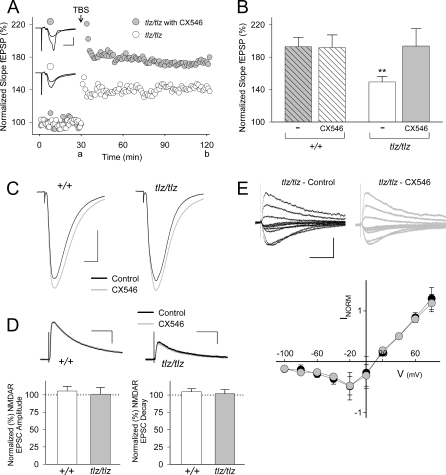
The Ampakine CX546 Restores the tbLTP Deficit in Neto1-Null Mice and Increases AMPAR, but Not NMDAR, EPSC Amplitude at Schaffer Collateral-CA1 Synapses(A) Scatter plots of normalized fEPSP slope plotted every 1 min from two individual representative Neto1-null slices without (white circle) or with (gray circle) CX546 (25 μm). When present, CX546 was applied to ACSF beginning 20–30 min before theta-burst stimulation. Theta-burst stimulation (TBS) was delivered to Schaffer collateral-CA1 synapses at the 30-min time point. The fEPSP slope was normalized with respect to the mean slope of fEPSPs recorded during the 10-min period immediately before theta-burst stimulation. Inset: average of six consecutive fEPSPs recorded at the times indicated (a or b; scale bars: 10 ms, 0.5 mV).(B) Histogram showing theta-burst stimulation-induced increase in fEPSP slope 90 min after theta-burst stimulation in slices from Neto1-null mice (tlz/tlz) without CX546 (-, white bar; n = 17 slices) and with CX546 (filled bar; n = 9 slices) and in Neto1+/+ mice without CX546 (-, filled hatched bar; n = 20 slices) and with CX546 (white hatched bar; n = 7 slices). Results are expressed as a percentage of normalized slope fEPSP. **, p < 0.01 versus tlz/tlz with CX546 (filled bar).(C) Representative traces show AMPAR EPSCs (held at −70 mV) before (black traces) and 20 min after CX546 (25 μM; gray traces) administration in hippocampal slices from Neto1+/+ (+/+) and Neto1-null (tlz/tlz) mice. Each EPSC is the average of six consecutive traces. Scale bars: 20 ms, 200 pA.(D) Representative traces show NMDAR EPSCs (+60 mV) before (black traces) and 20–30 min after CX546 (25 μM; gray traces) administration in hippocampal slices from Neto1+/+ (+/+) and Neto1-null (tlz/tlz) mice. Each EPSC is the average of six consecutive traces. Scale bars: +/+, 100 ms, 75 pA; tlz/tlz, 100 ms, 35 pA. Below: Histogram of pharmacologically isolated NMDAR EPSC amplitude (left) or decay (right) from CA1 neurons in hippocampal slices from +/+ (n = 8 neurons) and tlz/tlz (n = 6 neurons) mice 20–30 min after CX546 administration (25 μM; filled bars). Results are expressed as a percentage of NMDAR EPSC amplitude or decay with the amplitude or decay in +/+ and tlz/tlz slices before CX546 treatment normalized to 100% (dotted line).(E) Top: superimposed NMDAR EPSC traces at V
m from −100 to +80 mV in steps of 20 mV (scale bars: 100 ms, 70 pA) from a tlz/tlz hippocampal CA1 neuron before (black traces) and 20 min after CX546 administration (gray traces). Bottom: Summary scatter plot shows current-voltage (I-V) relationship for pharmacologically isolated NMDARs before (black circles) and after CX546 administration (gray circles) from five tlz/tlz hippocampal CA1 neurons. Error bars represent ± standard error of the mean (SEM).